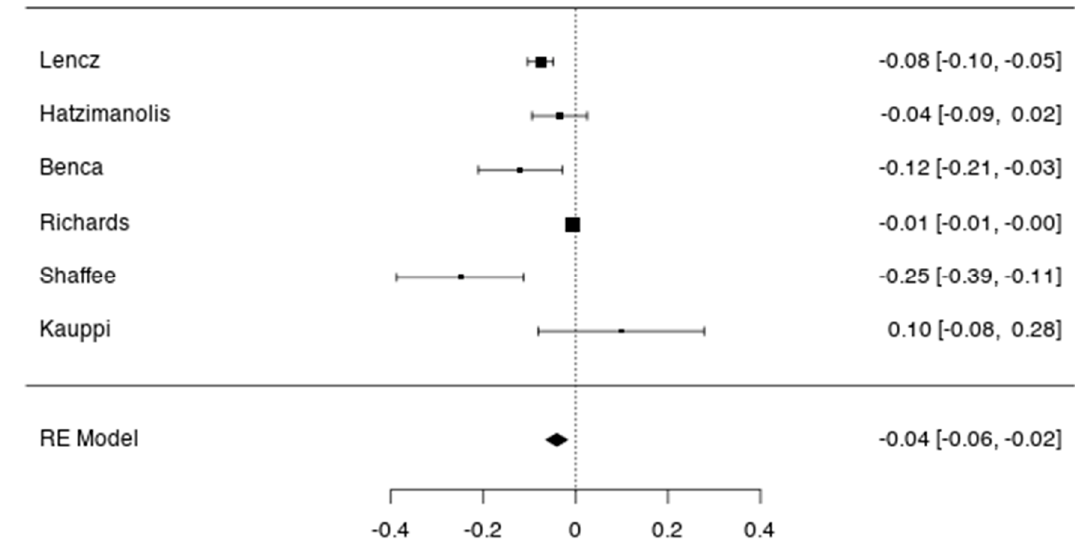
Figure 1. Forest plots of correlation between the genetic risk of schizophrenia and cognition in general and healthy participants. Error bars represent the 95% confidence intervals of the mean.